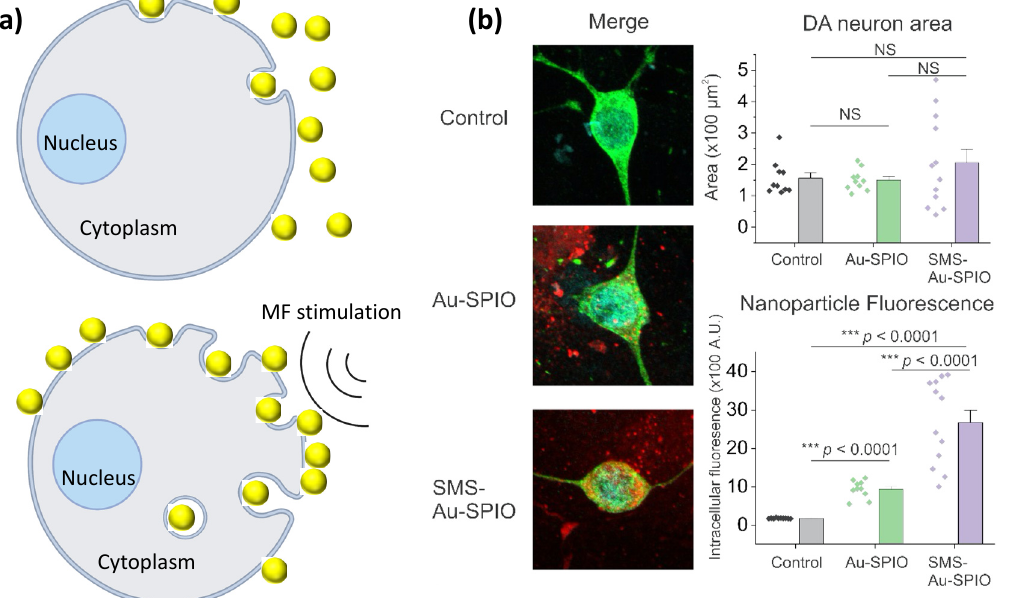
Figure 3. MF stimulation on enhancing cellular uptake ( a ) Schematic illustration of how MF stimulation enhances the cellular uptake of magnetic NPs by strengthening the sedimentation process of NPs onto the cell membrane; ( b ) confocal-microscope images showing the enhanced cellular uptake of SPIO–Au NPs into midbrain dopaminergic neurons under the stimulation of static MF. Grey bar represents Control group; Green bar represents Au-SPIO group; Purple bar represents SMS-Au-SPIO group. *** p < 0.001 was statistically considered significant difference. NS = not significant. Copyright 2022 by ACS. (Created with BioRender.com on 1 April 2022). Table 1. Summary of the effects of external stimuli, including MF and focused US, on enhancing cellular uptake and BBB transfer of magneto-plasmonic NPs.